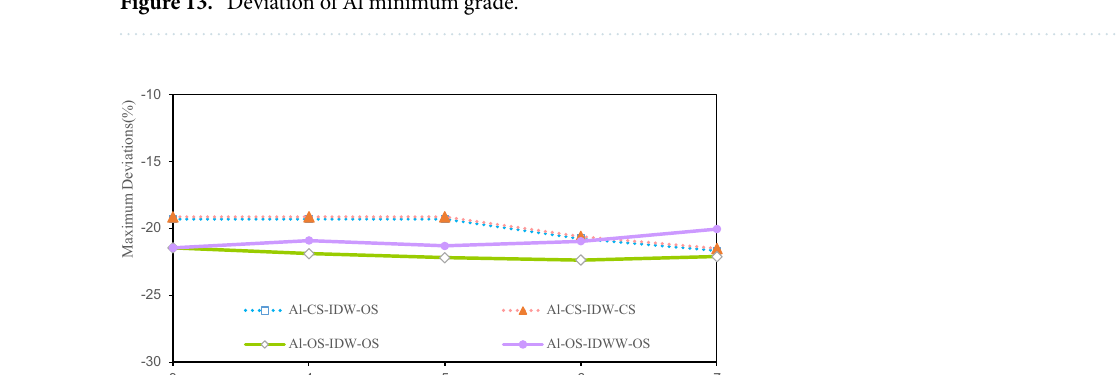
Figure 13. Deviation of Al minimum grade.